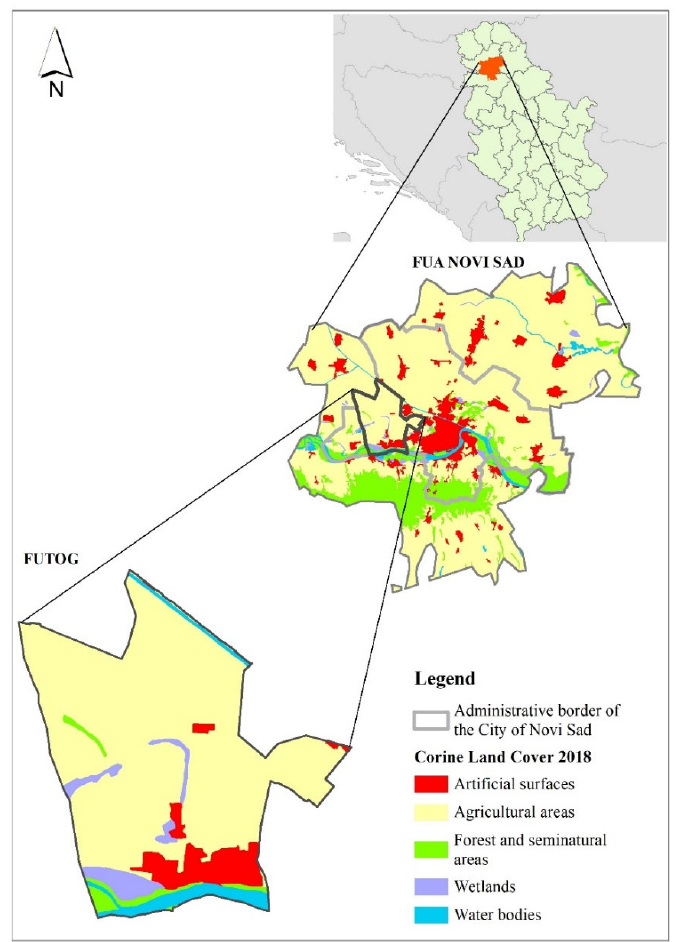
Figure 1. Location and land cover characteristics of the study area.